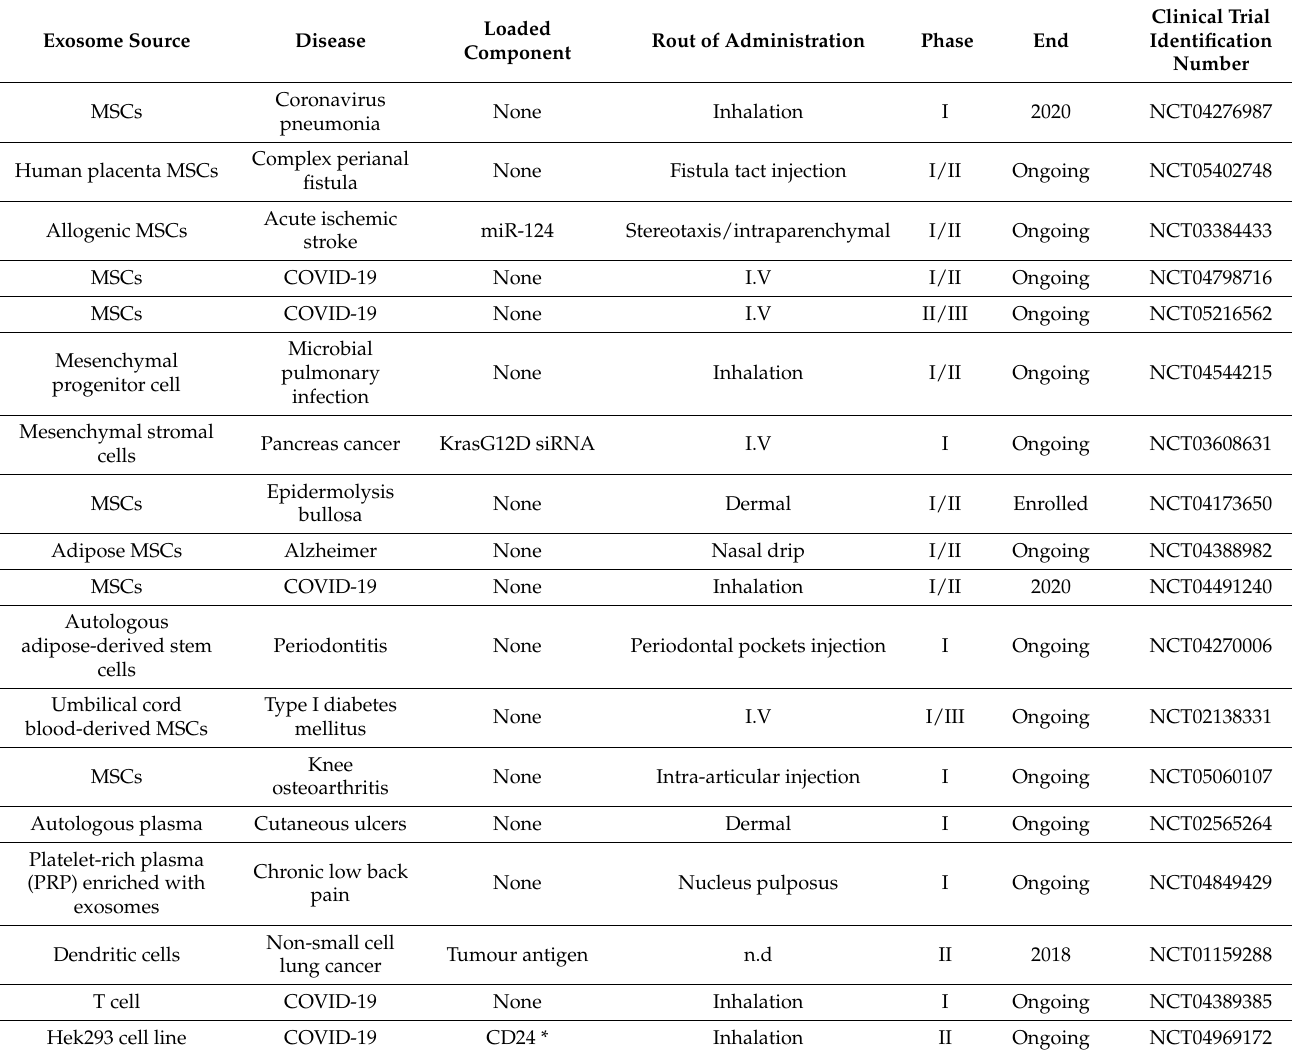
Table 1. Current submitted clinical